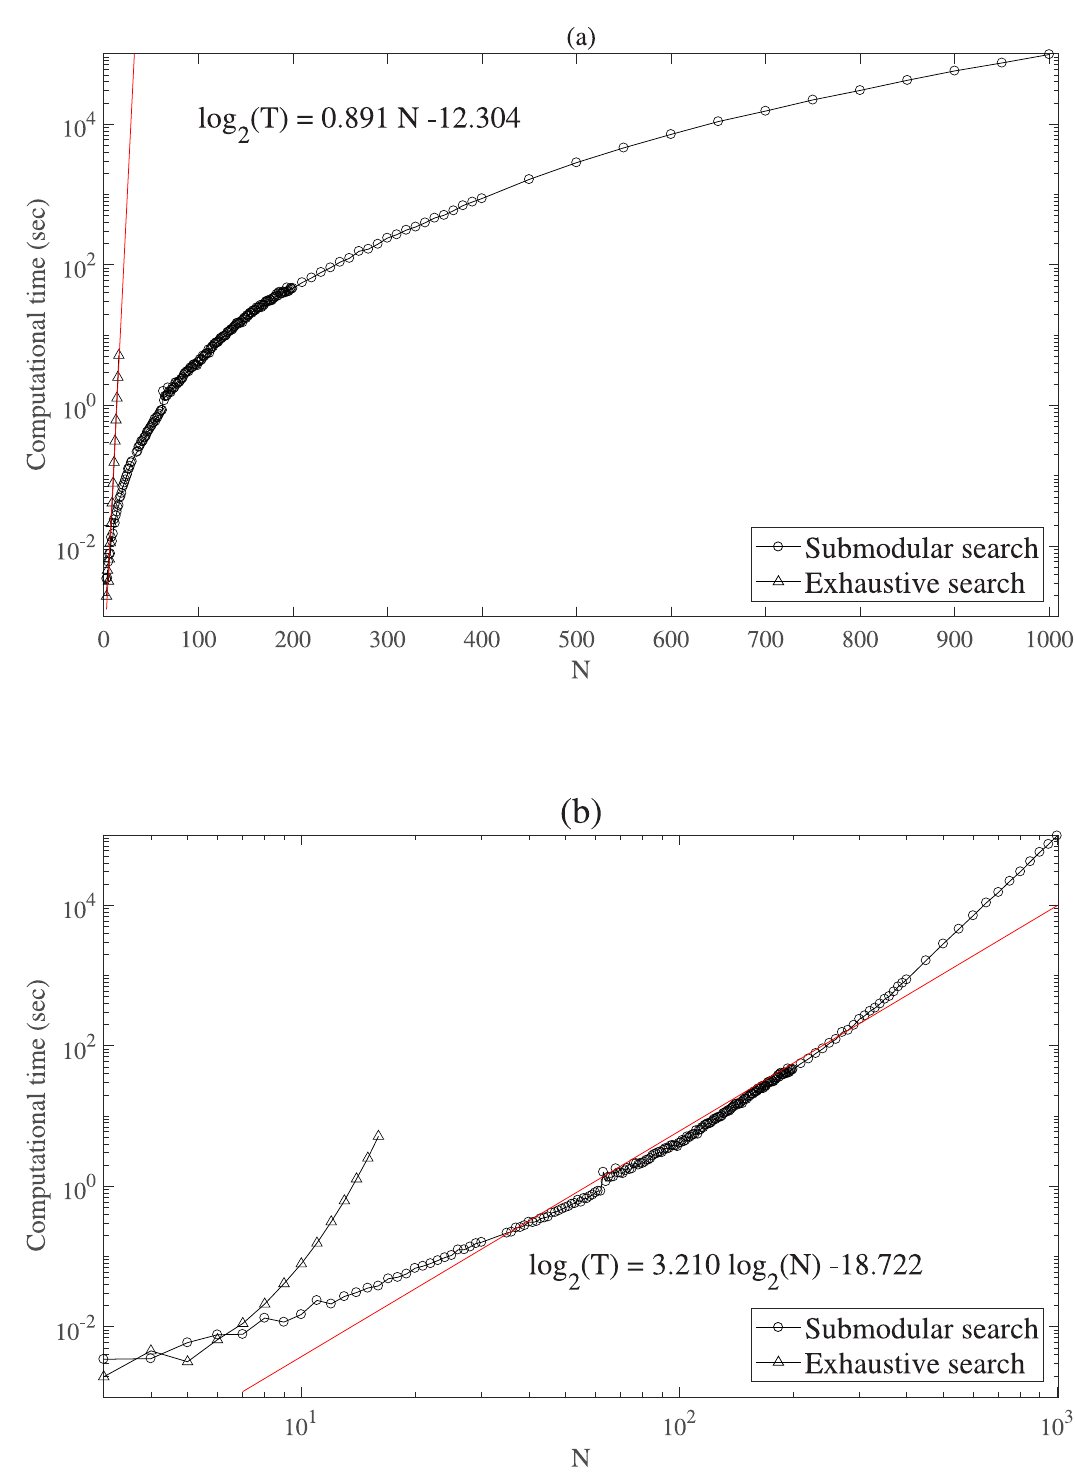
Fig 2. (a) The semi-logarithm plot and (b) log-log plot of the computation time for the two searches.